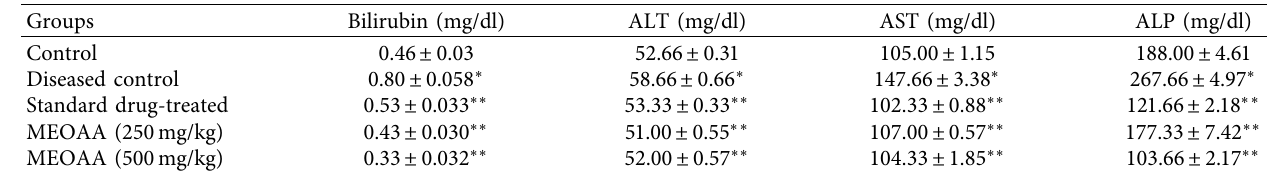
Figure 3: Histopathological examination of rat urinary bladder from the control group (a), diseased control (b), standard drug-treated (c), MEOAA (250 and 500mg/kg)-treated groups (d and e) in the cyclophosphamide-induced cystitis model. (a) shows normal transitional epithelial lining and intact mucosa and (b) shows focally ulcerated mucosal lining. The interstitial tissue and cleaves of muscle coats contained scattered mixed inflammatory cells. There was focal urinary bladder necrosis, (c) normal contracted transitional epithelium of urinary bladder, and (d) shows intact looking transitional epithelial lining. Congestion in the submucosa was seen, (e) intact uniform- looking transitional epithelial lining. The muscle coats were arranged in a normal pattern. No evidence of any disease, granuloma, or malignancy was seen. Table 4: Effect of A. arvensis on